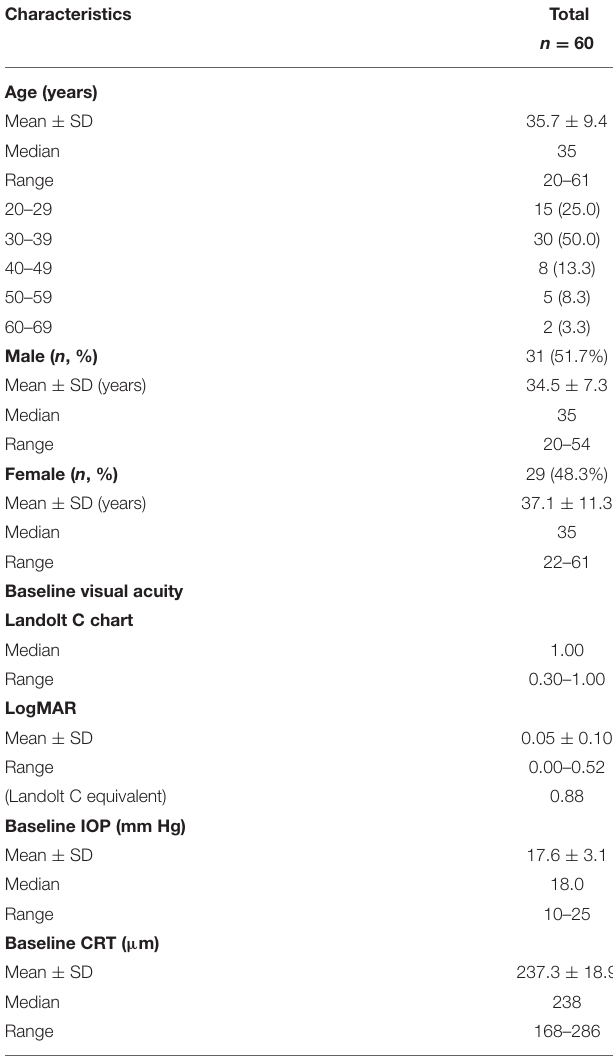
TABLE 1 | Clinical characteristics of the study